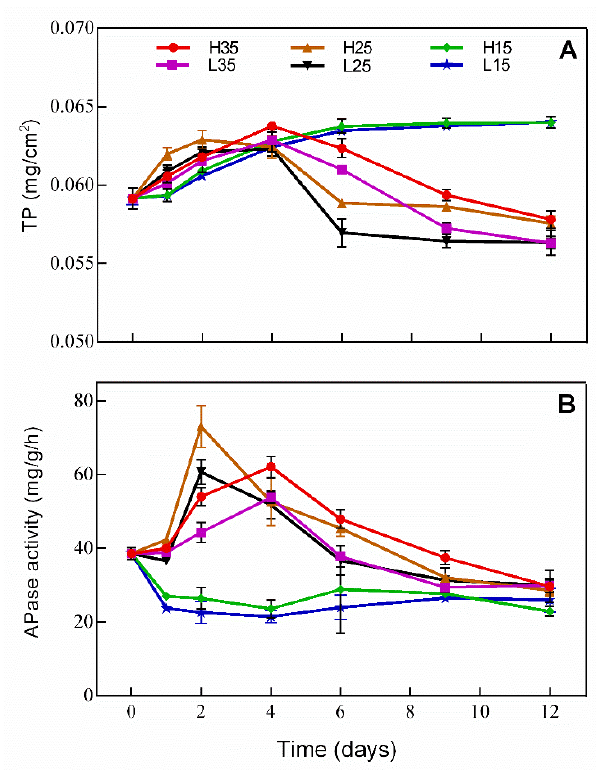
Figure 5. Changes in ( A ) TP and ( B ) APase activity in periphyton in different treatments during the experiment.